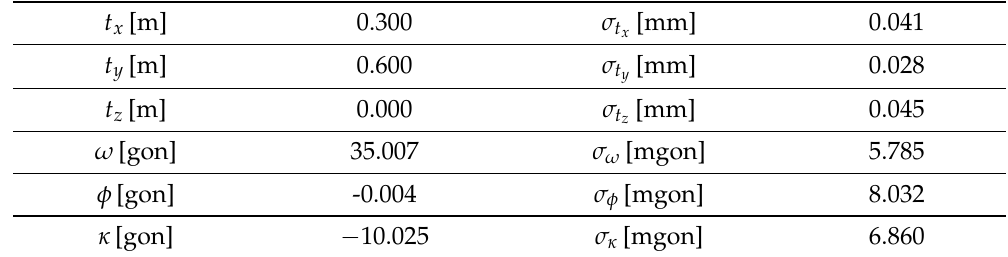
Table 7. Results of the estimated rigid body movement after having extended S CS (data set V40, a = 0, n CS = 19, n CS , ex = 28) [30].